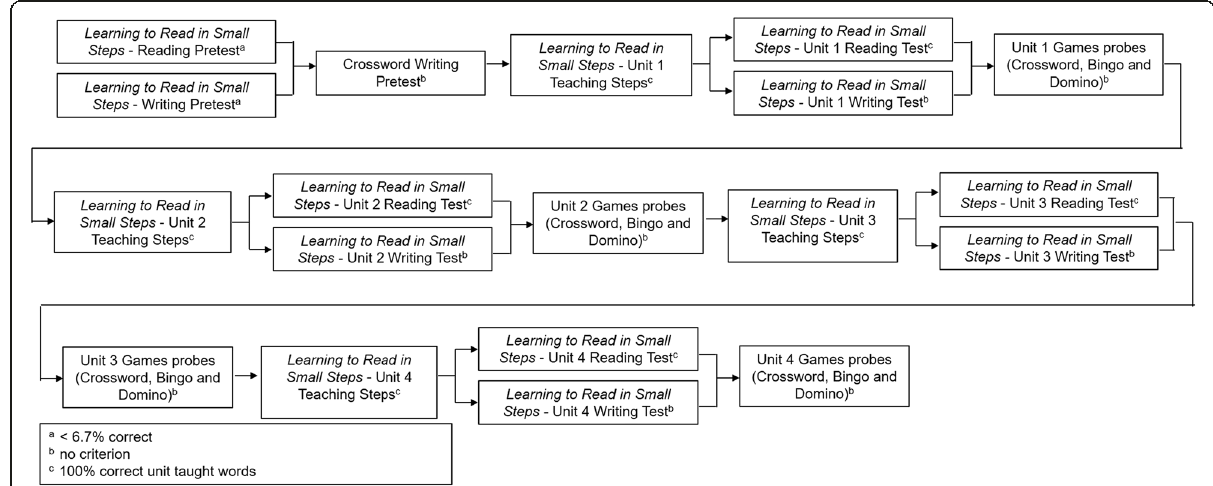
Fig. 2 Diagram depicting the pretests, the four teaching units comprising the computerized program Learning to Read in Small Steps , target relations, and mastery